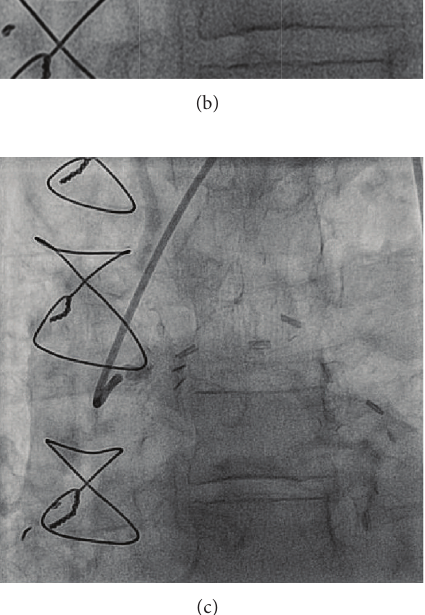
Figure 3: (a) Occluded SVG to RCA. (b) Occluded SVG to circumflex. (c) Occluded SVG to obtuse marginal